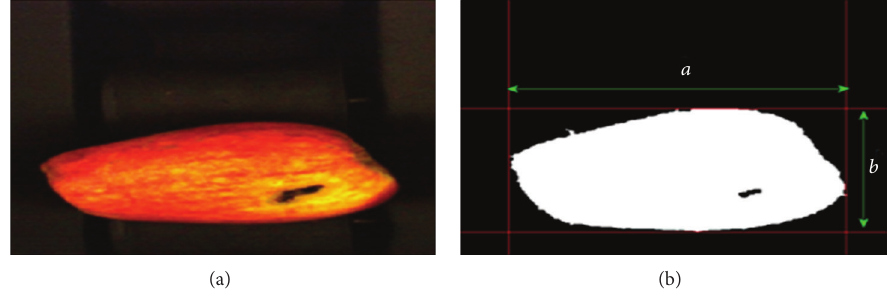
Figure 8: Original apple image (a) and masked image